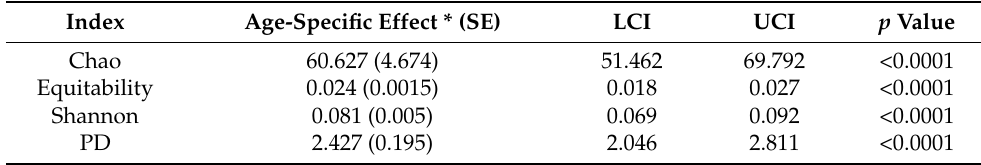
Figure 3. Effect of increasing age on alpha diversity: Alpha diversity of the gut microbiota of all children was assessed in QIIME Version 1.5 using taxon-based alpha diversity measures ( a ) Chao, ( b ) equitability, ( c ) Shannon diversity indices, and ( d ) phylogenetic-based alpha diversity measure phylogenetic diversity. The effect of increasing age on these alpha diversity measures was assessed using a linear mixed-effects model adjusted for gender, residential location, and reported diarrheal episodes. Table 3. Relationship of Age and Alpha Diversity